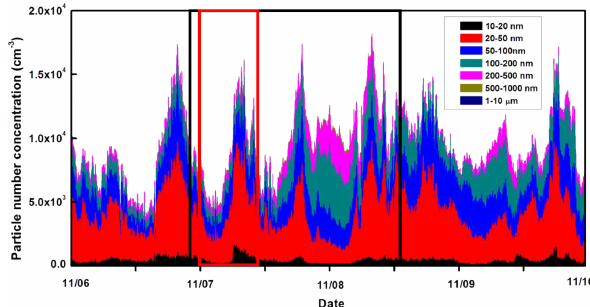
Figure 4. Hourly mean particle number concentrations of different sub-size bins, the foggy–hazy case is marked in red open boxes and hazy case in black.